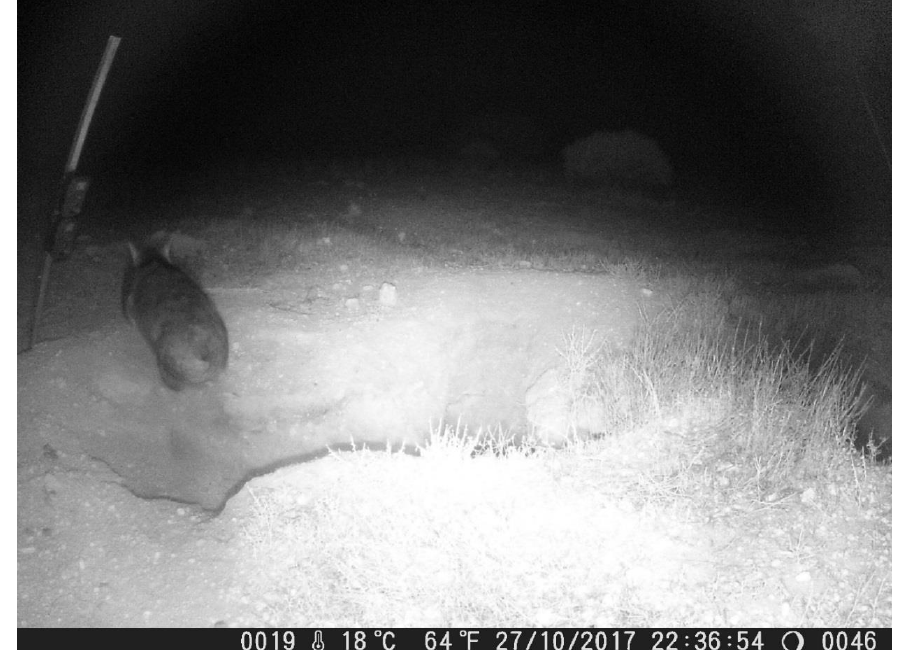
Figure 6. While this image of a wombat emerging from its burrow was captured on both the medium-range video and still cameras (medium-range still camera image shown)—which were oriented side-on to the burrow entrance—it was not recorded on either of the short-range cameras (the pole in the image) which were facing directly at the burrow entrance. This highlights the potential for single camera studies to fail to capture imagery of some animals even if they are clearly within their field-of-view, and for the need to consider the orientation of cameras in relation to expected target motion. In regard to our calculation of the number of wombats/active burrow, our figure of 0.43 for the Murraylands is virtually identical to previous figures calculated for the region of 0.43 [6], 0.4389 [2,13]